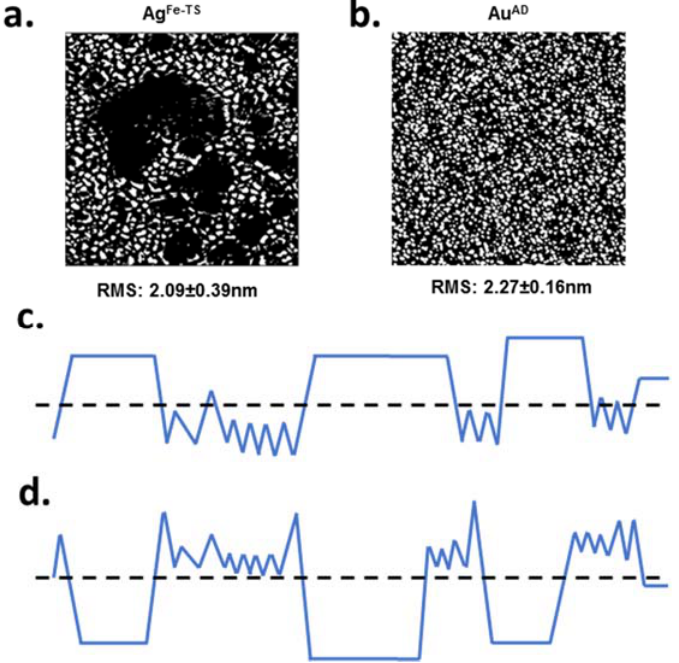
Figure 8. ( a ) Images of grains on Ag Fe-TS substrate; ( b ) Images of grains on Au AD substrate; ( c ) Schematic illustration of the substrates from previous studies; ( d ) Schematic illustration of the substrates of Wang et al. ’s